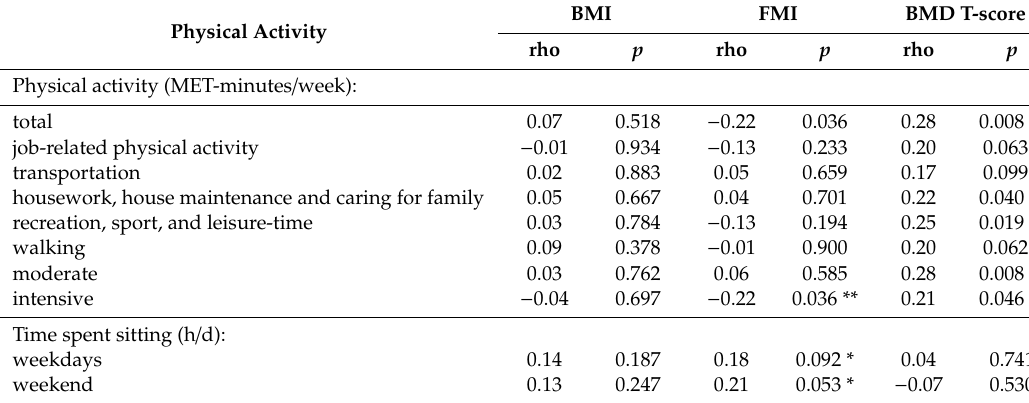
Table 6. Relationship between physical activity and body mass index (BMI), fat mass index (FMI), and bone mineral density expressed as